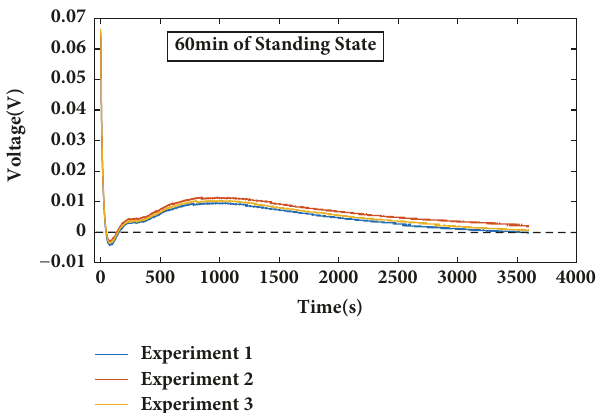
Figure 9: Comparison of the error between the model simulations and experiments measurements at self-healing time of 60